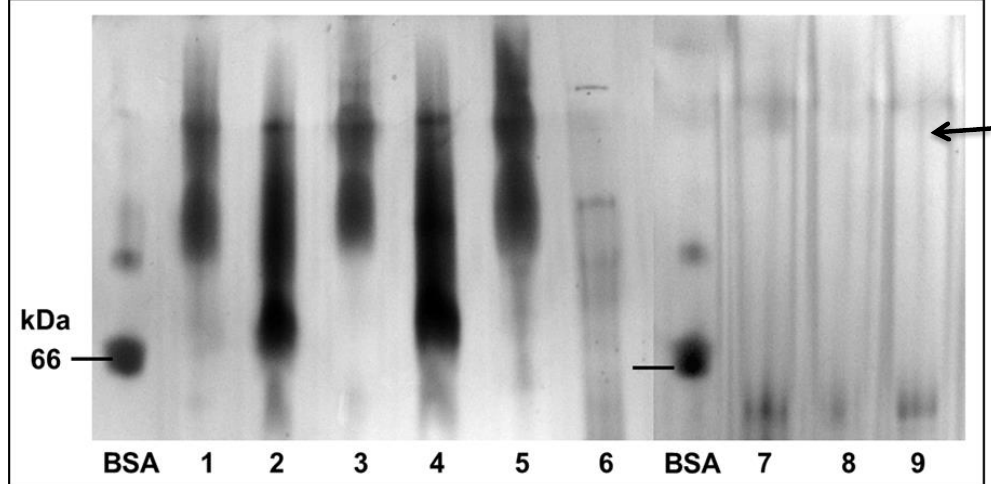
Figure 3. The native Blue-PAGE of mung bean albumin extracts and 30 kDa MWCO filtrates. BSA = bovine serum albumin. BSA was used as a reference protein. ( 1 ) Water pH = 7.5 extract, (2) Albumin isolate from water pH = 7.5 extract, ( 3 ) Water pH = 3.0 extract, ( 4 ) Albumin isolate from water pH = 3.0 extract, ( 5 ) Borate buffer pH = 8.3 extract, ( 6 ) Albumin isolate from borate buffer pH = 8.3 extract. Samples on lanes ( 2 ), ( 4 ) and ( 6 ) were filtered using a 30 kDa MWCO centrifugal filter to produce the permeates on ( 7 ), ( 8 ) and ( 9 ), respectively. Arrows indicate the protein fractions that are most likely to be mung bean albumin according to their molecular weight.